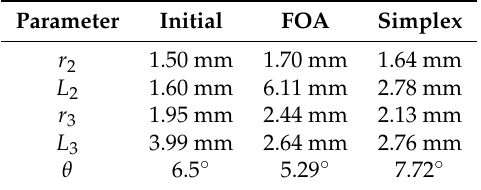
Table 3. Values of the Potter horn design parameters obtained by different